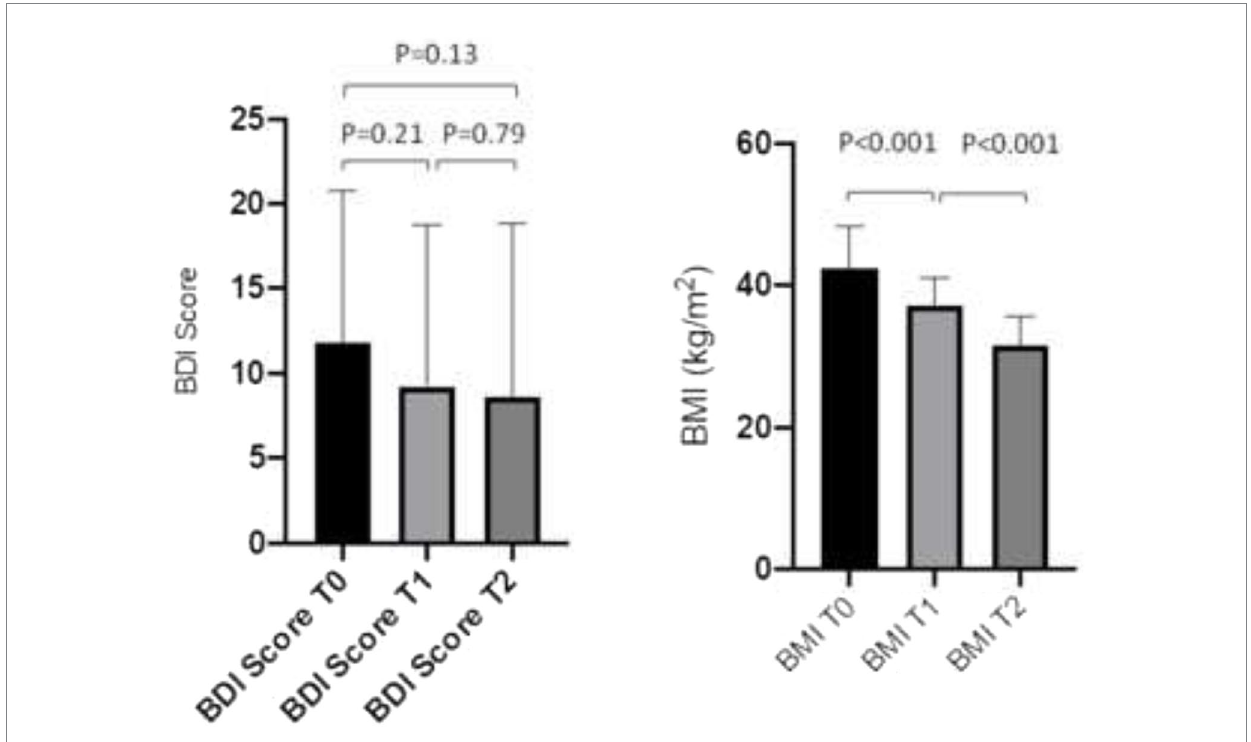
FIGURE 4 BDI score and BMI at beginning of the study (T0), and 1 month (T1), and 6 months (T2), after bariatric surgery ( n = 46). Data are mean ±